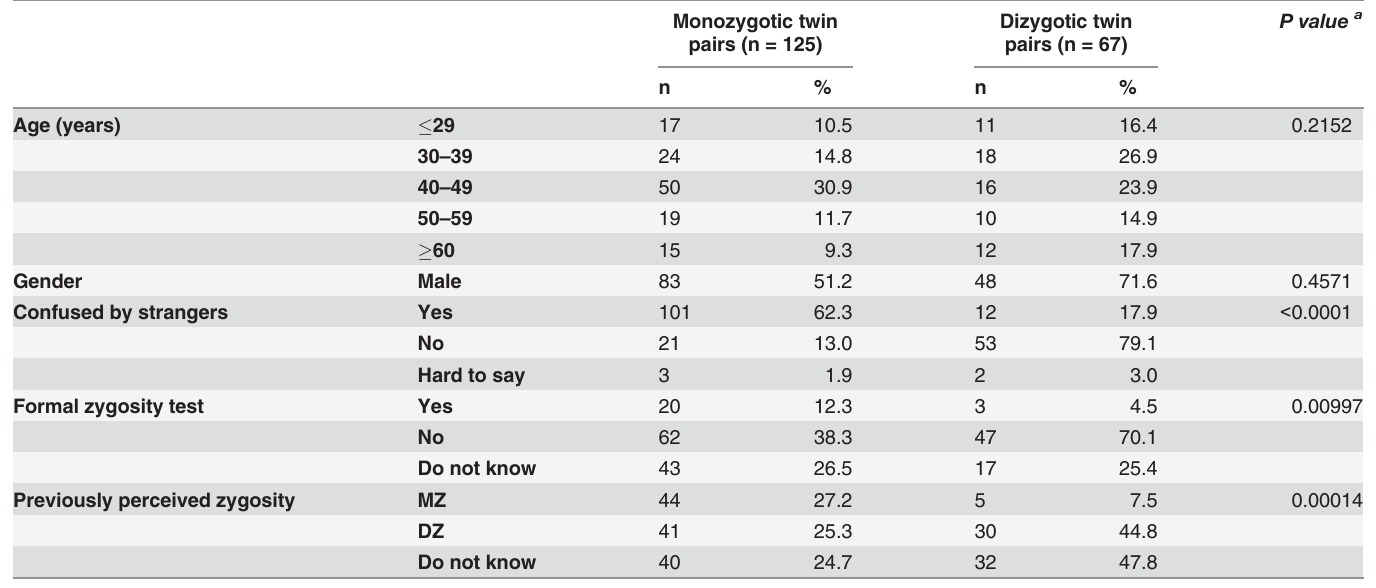
Table 1. Characteristics of the 192 same sex twin pairs who were analyzed for questionnaire based zygosity